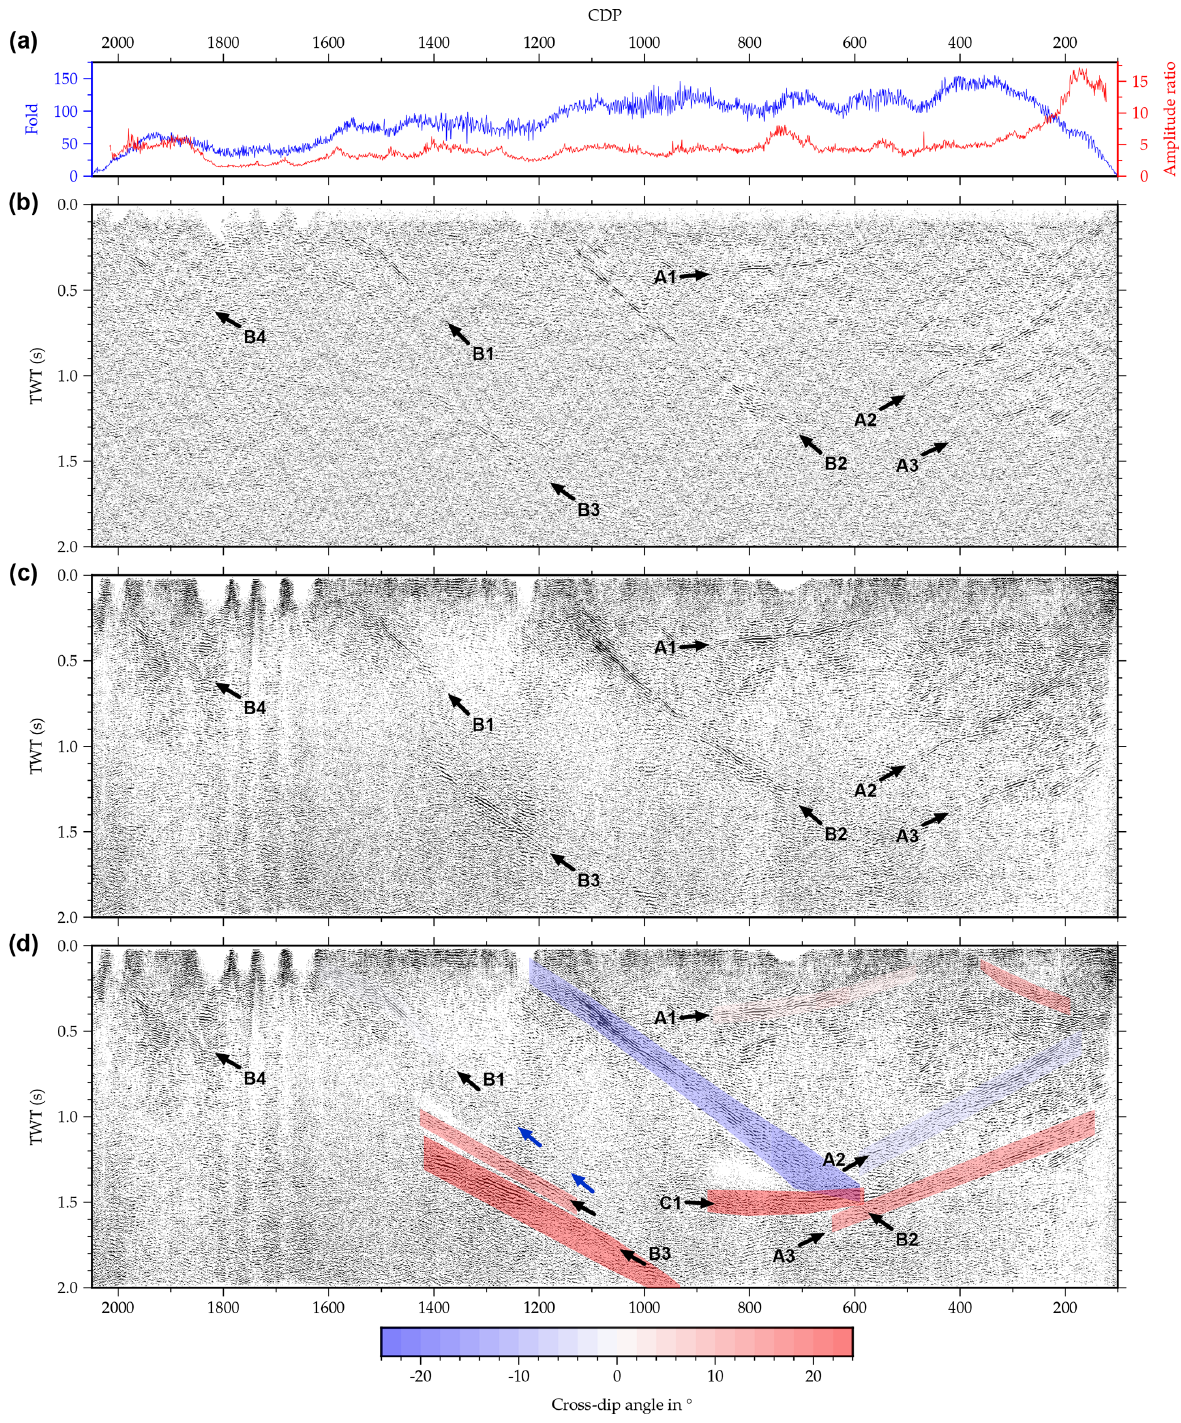
Figure 10. Comparison between the original processing of the Burträsk dataset and the reprocessing at different stages: (a) fold distribution along the profile and mean amplitude ratio between the first 200ms of data and the background noise; (b) original stack from Juhlin and Lund (2011); (c) reprocessed stack without cross-dip correction; (d) reprocessed stack with cross-dip correction overlain by the cross-dip angles used in the correction. The blue arrows indicate a possible continuation of reflection B1. The comparison of panels (b) and (c) highlights improvements due to the conventional reprocessing steps like statics, updated velocity model, etc., and the comparison of panels (c) and (d) illustrates the effects of the cross-dip